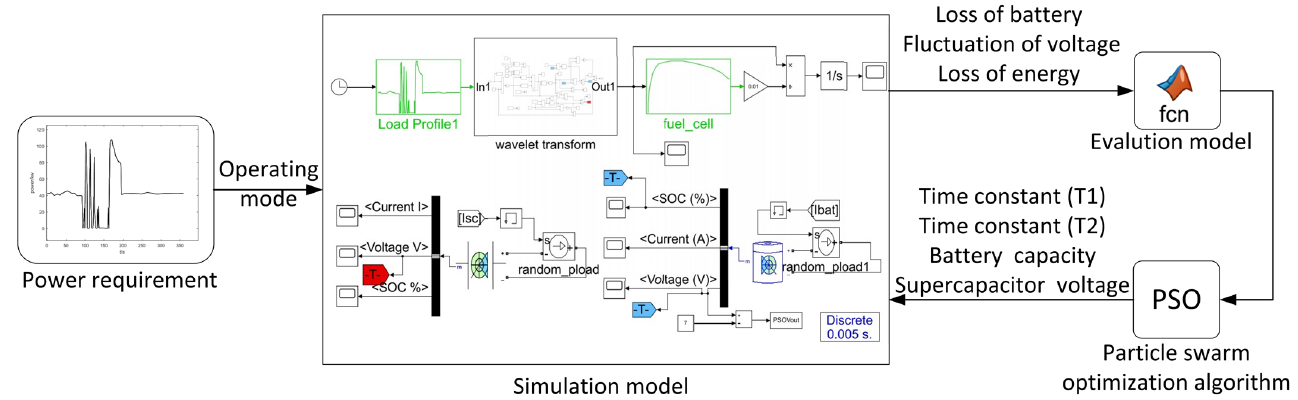
Figure 4. Structure diagram of particle swarm optimization algorithm.